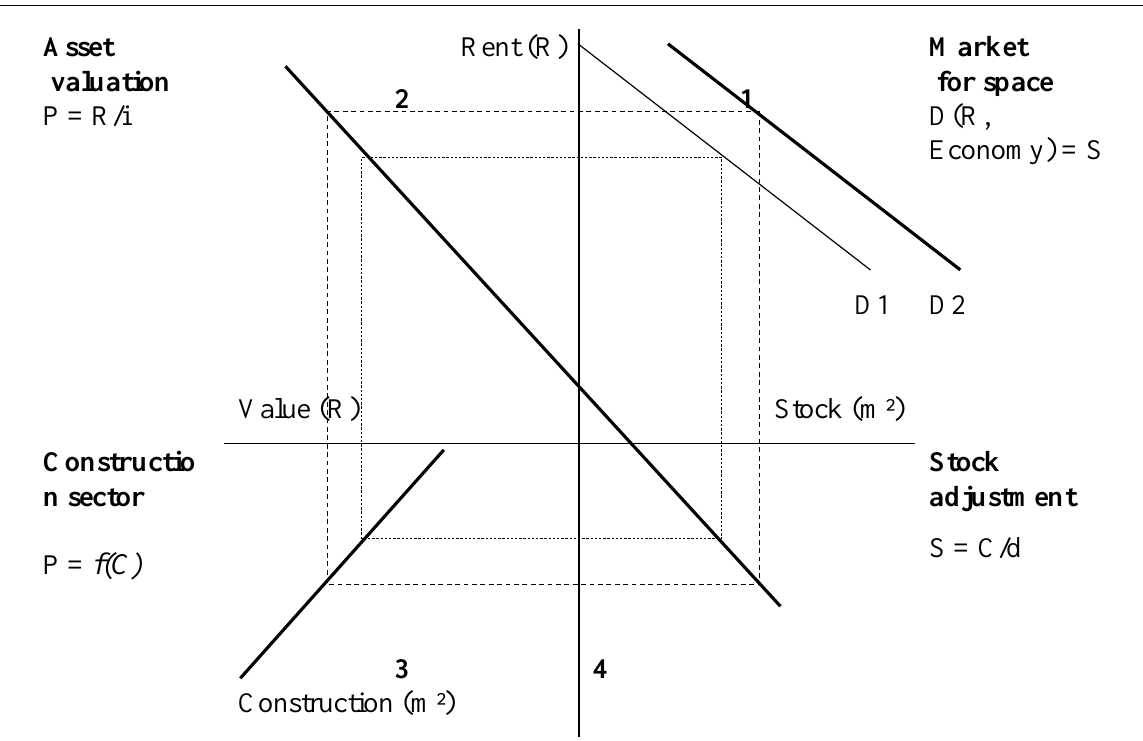
Figure 2: Demand shift in terms of the Pretoria